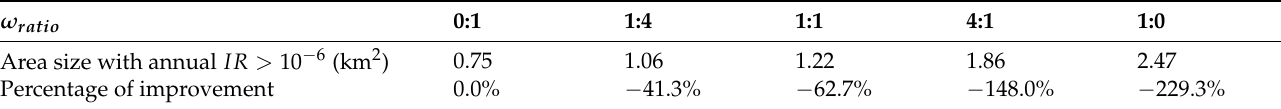
Table 2. Area size with high annual IR with different risk weight ratios.